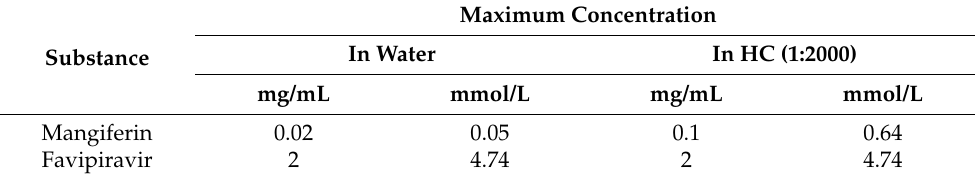
Figure 7. Particle size distribution in mangiferin ( a ) and favipiravir ( b ) solutions: black line—in water, pink line—in HC 1:2000. Table 1. Maximum concentrations of mangiferin and favipiravir solutions obtained using different